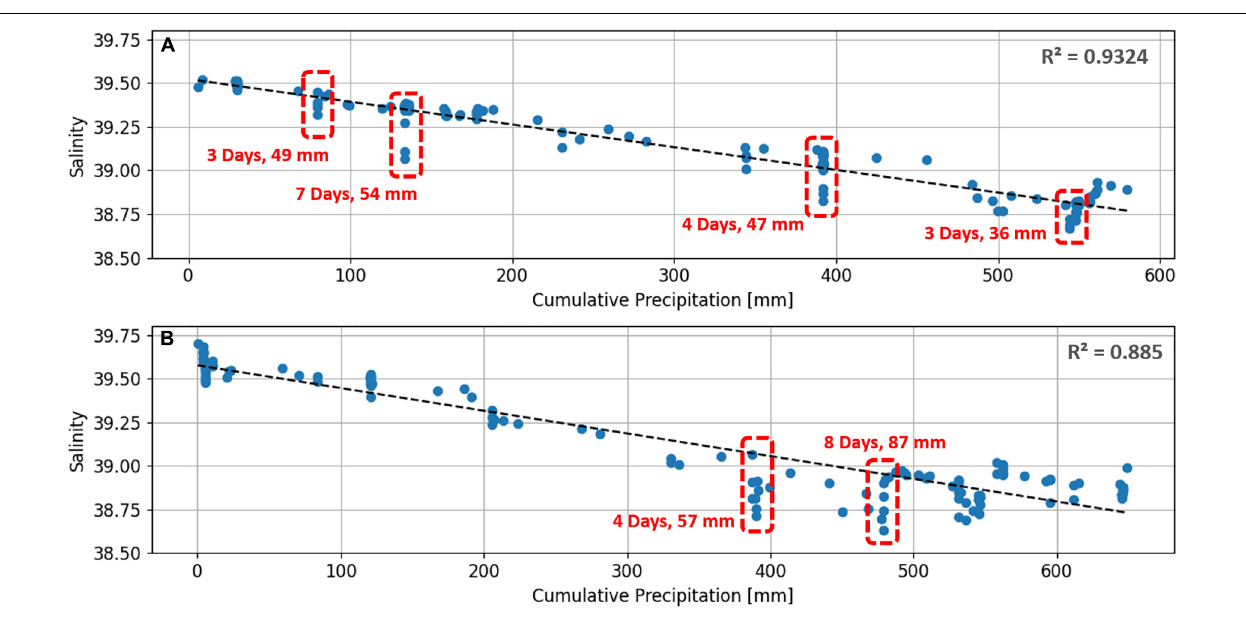
FIGURE 6 | Salinity measurements from Hadera monitoring station projected against winter cumulative precipitation for the winters of 2014–2015 (A) and 2019–2020 (B) . Calculated regression line are shown in dashed black lines (identical for both winter seasons, y = –0.0013x + 39.55). Red rectangles and adjoining text indicate storms where high precipitation levels were recorded coinciding with a salinity drop below the regression line. Storms duration and total precipitation are indicated in red